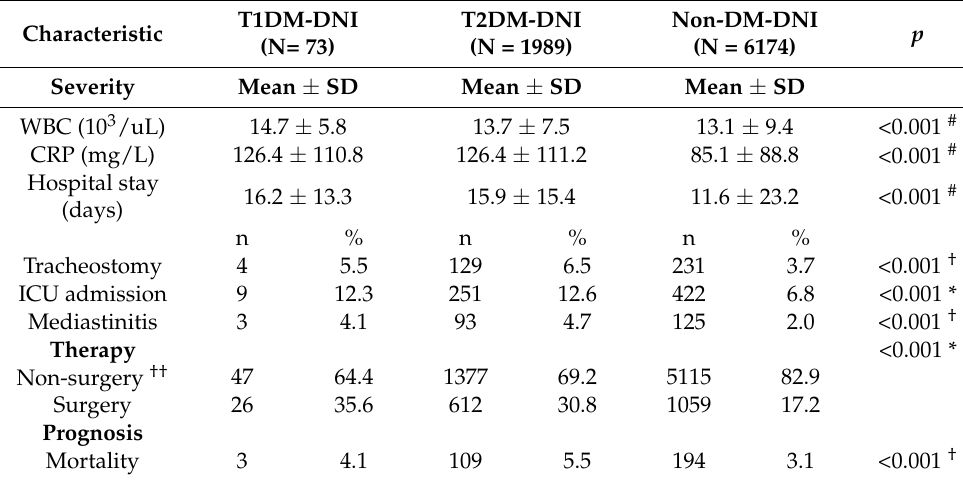
Table 2. Analysis of DNI severity, treatment, and prognosis in patients with